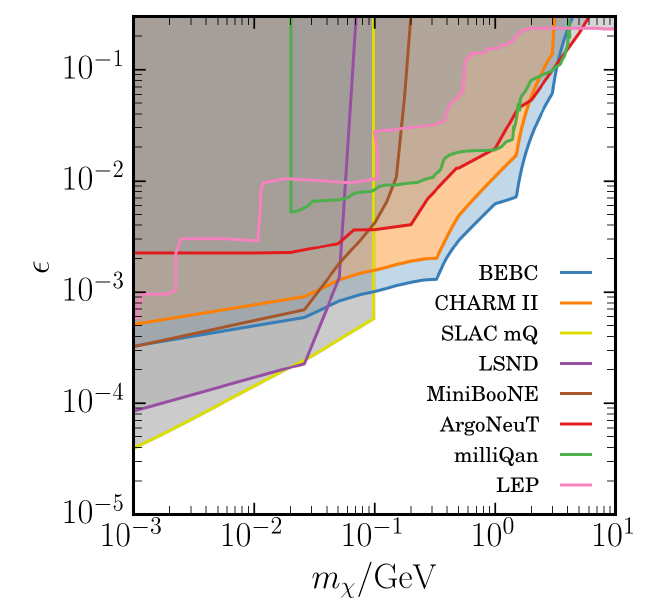
Figure 3: The 90% upper limit on the size of the millicharge ε = Q χ / e from CHARM II and BEBC. All regions shaded in grey are already excluded at 90% by: SLAC [ 4 ] ; LSND and MiniBoone [ 7 ] ; ArgoNeuT [ 9 ] ; milliQan [ 10 ] ; and LEP [ 12 ]